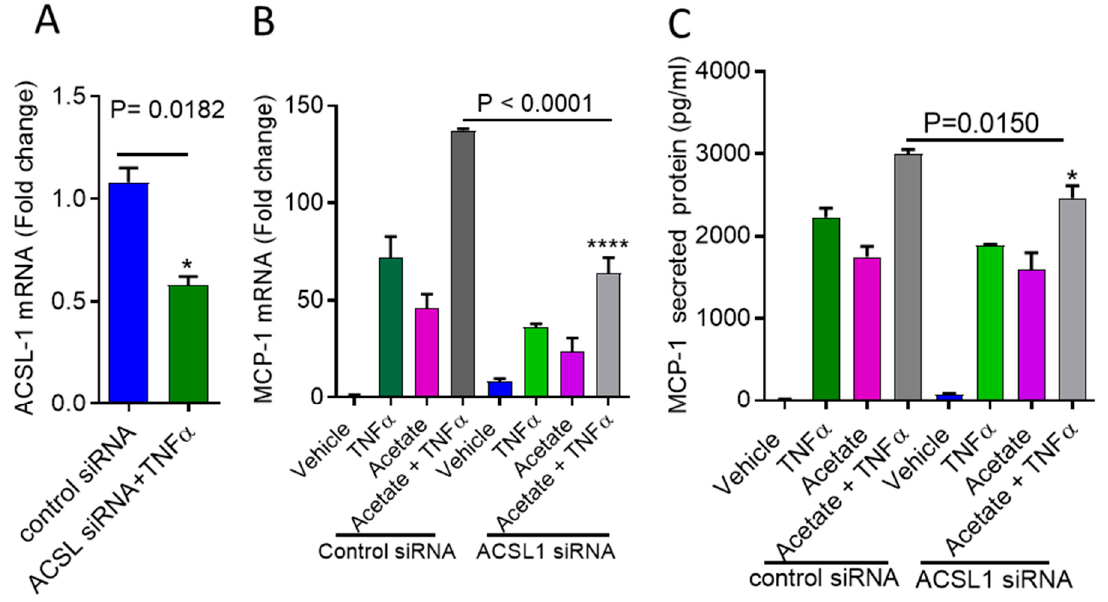
Figure 5. Acetate synergy with TNF α for MCP-1 production requires ACSL1. ( A ) THP-1 monocytic cells were transfected with either control or ACSL1 siRNA and incubated for 36 h. Real time PCR was done to measure ACSL1 expression. ( B , C ) ACSL1 deficient THP-1 cells were stimulated with acetate and TNF α . MCP-1 expression was determined. The results obtained from three independent experiments are shown. All data are expressed as mean ± SEM (n = 3). * p < 0.05; **** p < 0.0001.